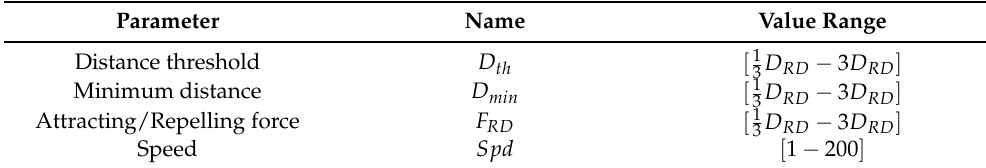
Table 1. Proposed parameters for the UAVs in the